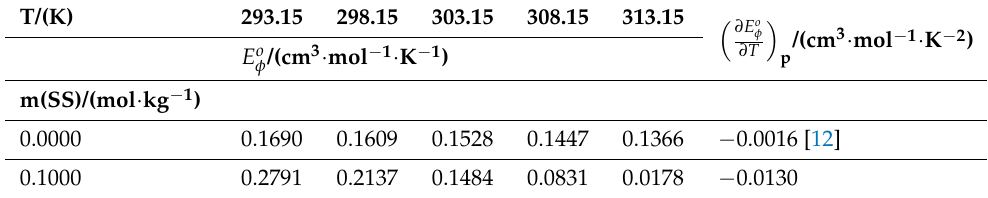
Table 4. Values of the limiting apparent molar expansibilities, E o in SS aqueous solutions in the temperature range from T = 283.15 to 313.15 K.